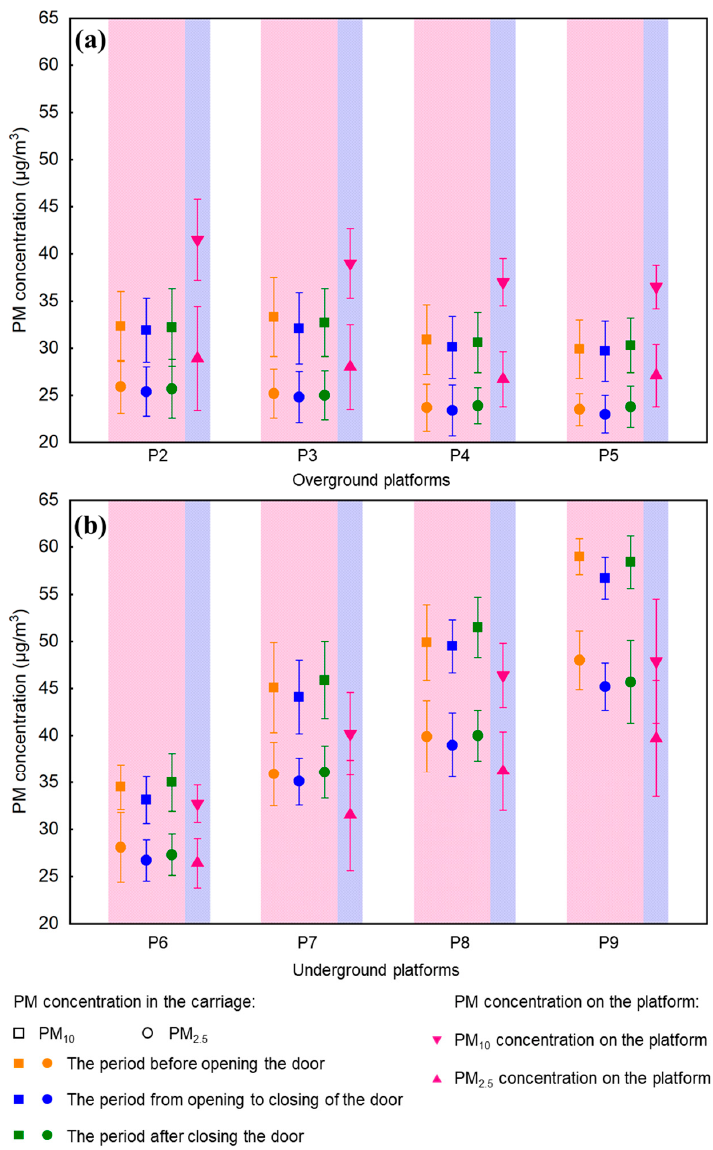
Figure 7. Variations of average PM concentrations in the metro carriage when the door was opened and closed on the platforms. ( a ) Overground platforms. ( b ) Underground platforms. The orange icons represent the average in-carriage PM concentrations for the period before the opening of the door. The blue icons represent the average in-carriage PM concentrations during the period from opening to closing of the door. The green icons represent the average in-carriage PM concentrations for the period after the closing of the door. Two pink triangles represent the PM concentrations on the platforms (one for PM 10 and another for PM 2.5 ).